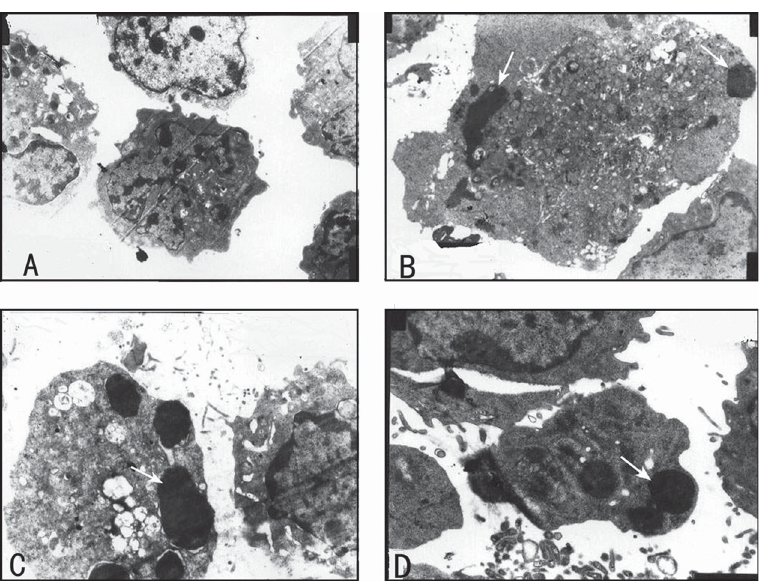
Figure 1. Transmission electron microscopy of untreated HL-60 cells (A) and cells treated with 40 µg/mL fraction FA-2-b-ß for 96 h (B-D). The typical nuclear features of apoptosis, such as marginal condensation of nuclear chromatin (arrows) and nuclear fragmentation (arrows) are shown in figures B-D. Magnification 4000X